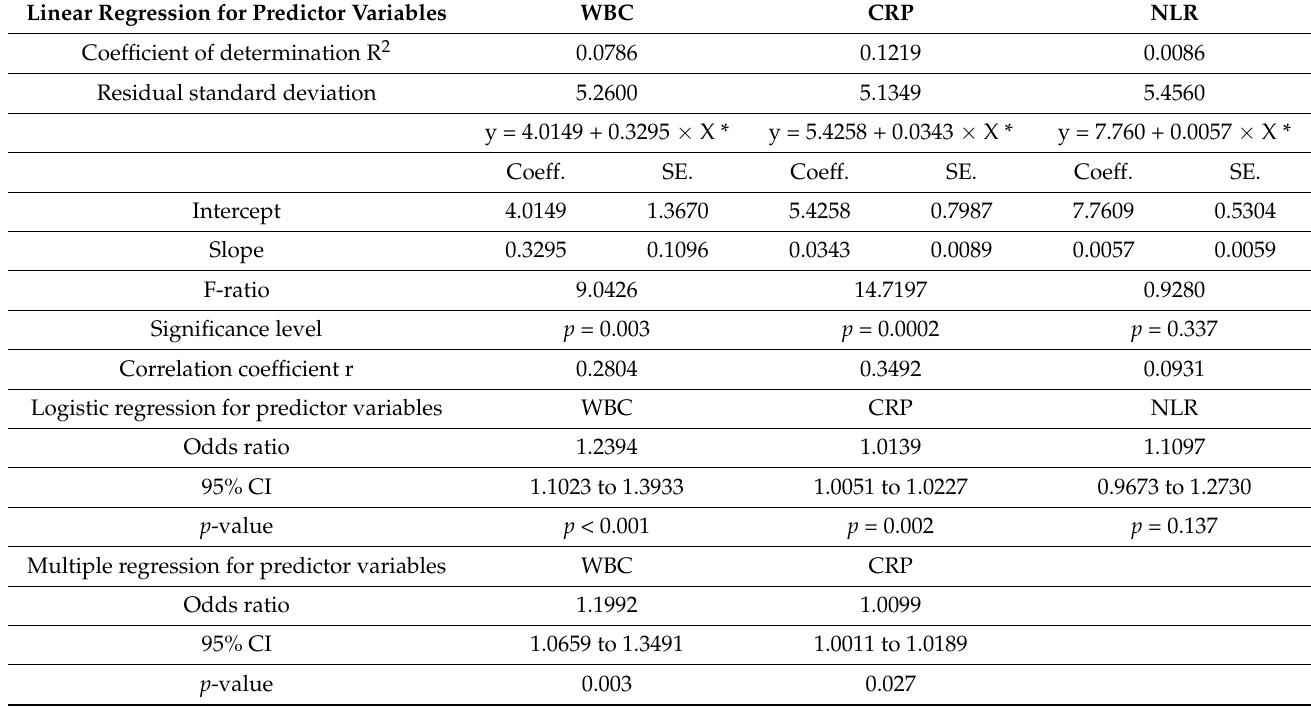
Table 3. Univariate and multivariate analysis for predictor